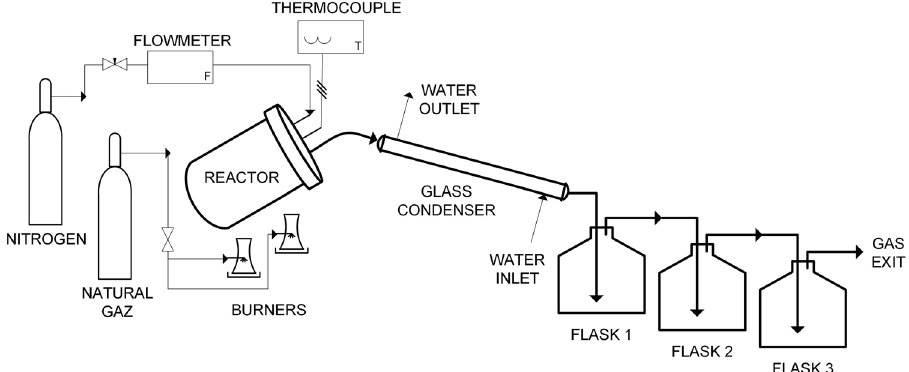
Fig. 1 Schematic representa- tion of laboratory-scale pyroly- sis set up to produce